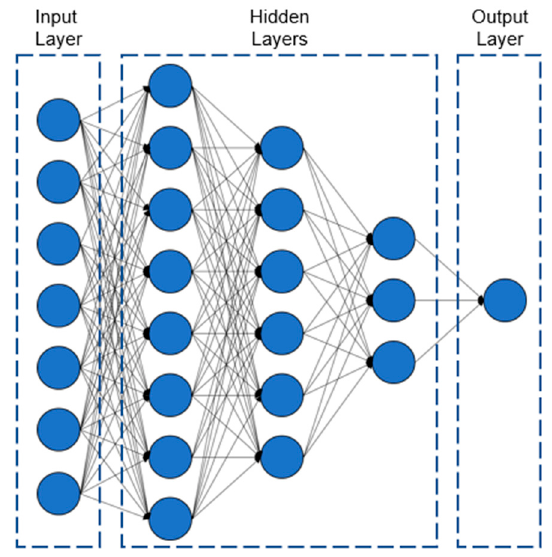
Figure 6. Developed FFNN with three hidden layers.